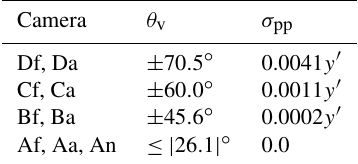
Table 5. Uncertainty estimate due to the plane-parallel radiative transfer assumption, based upon analysis by Frouin et al.